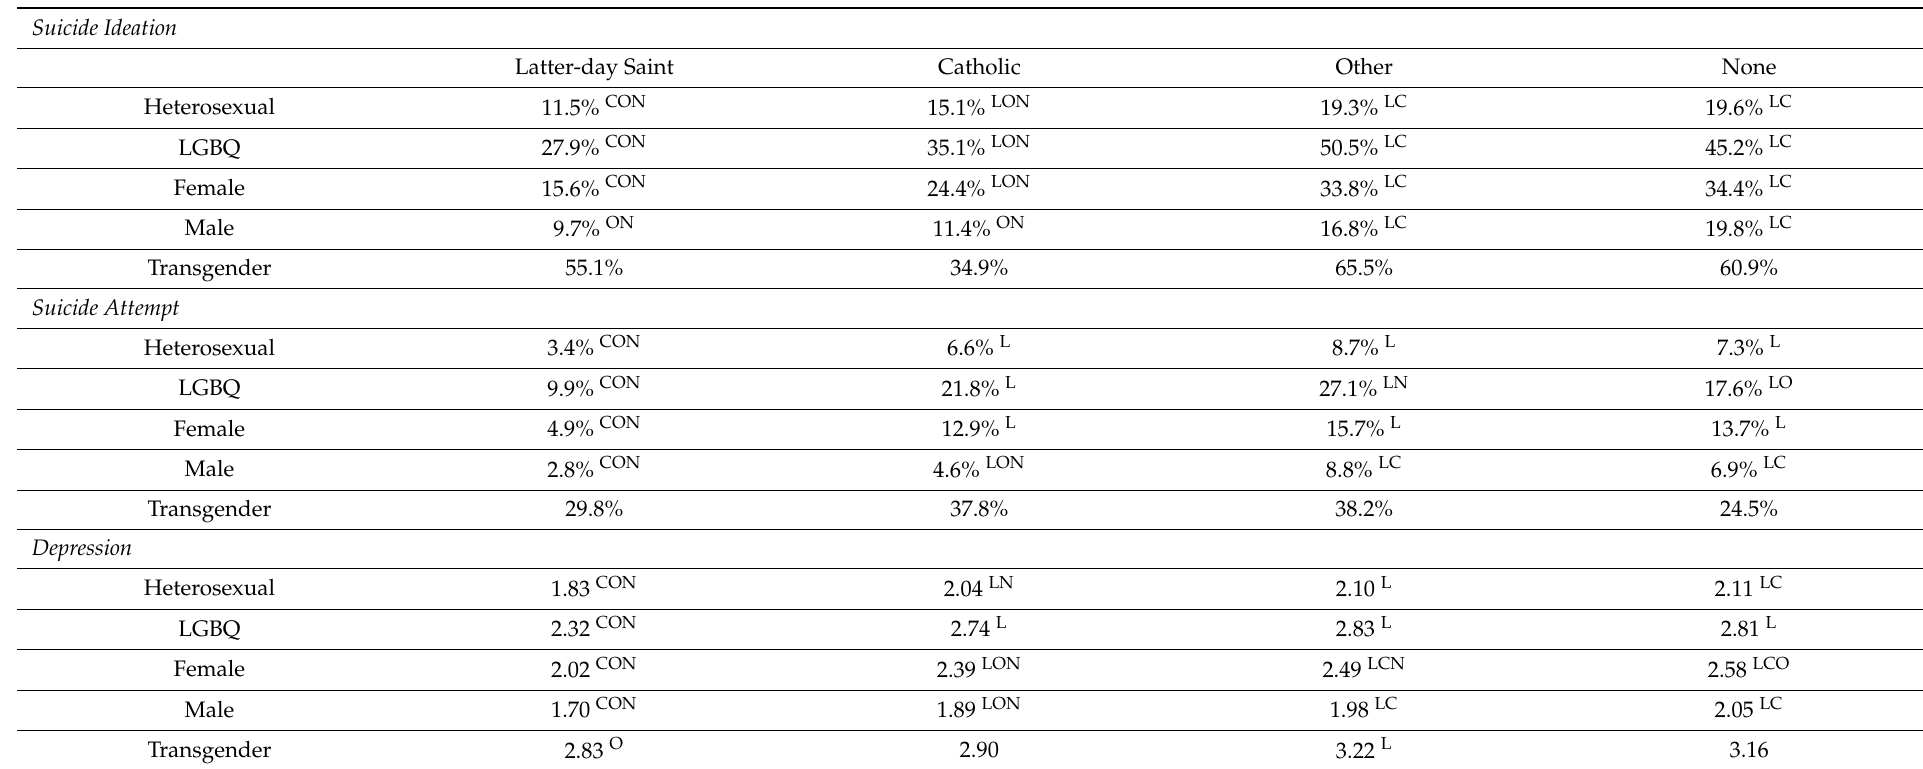
Table 2. Baseline rates/levels of suicide ideation, suicide attempt, and depression by sexual orientation and gender identity (n = 46,562). Suicide